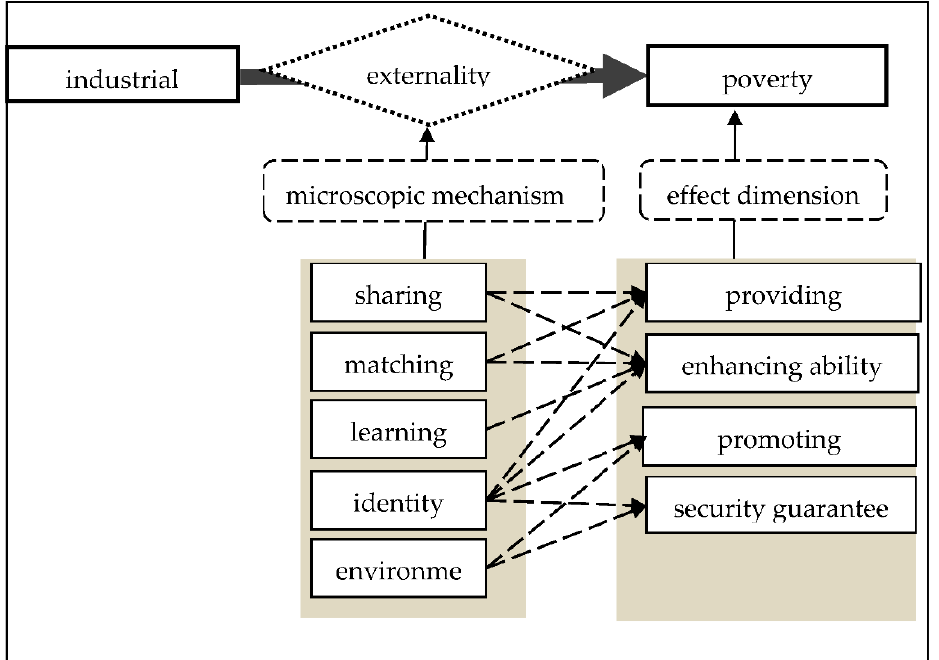
Figure 1. The conceptual model framework.